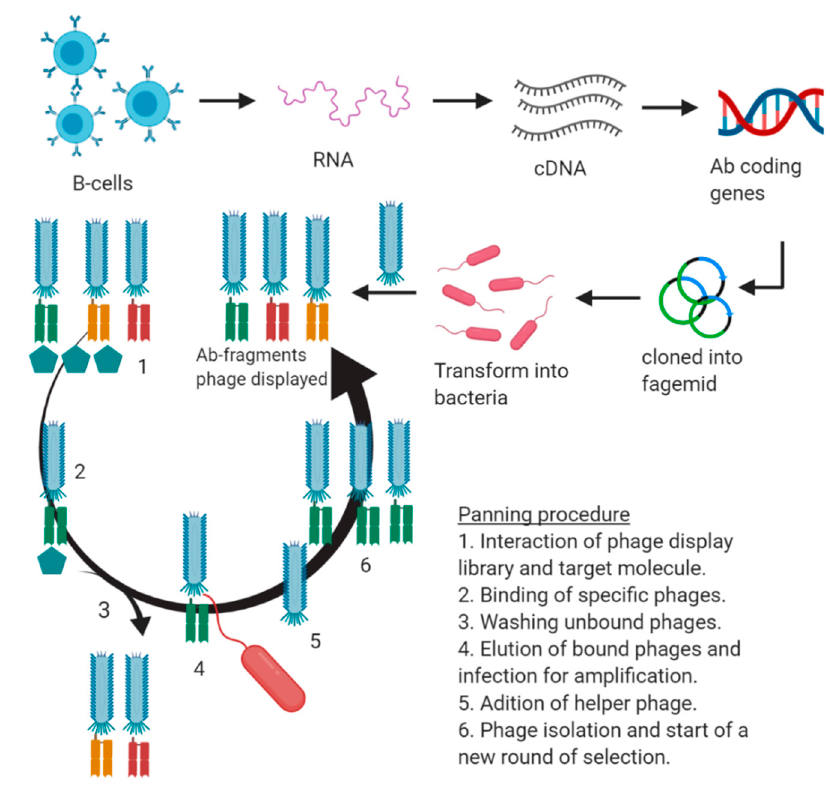
Figure 4. Construction and performance of a directed evolution process mediated of an immune library by phage display.